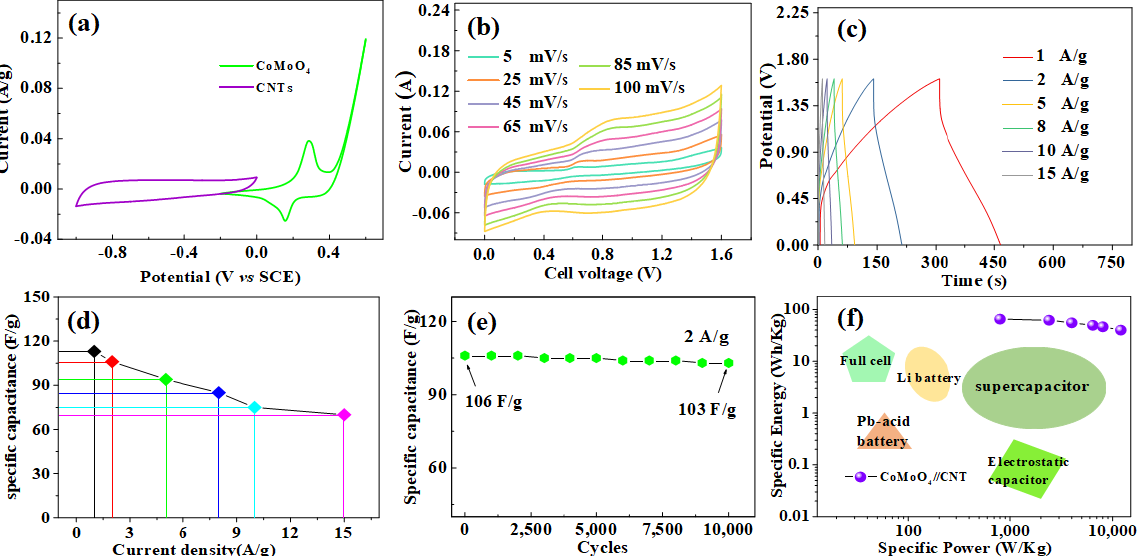
Figure 6. ( a ) CV curves of CNTs and pie-shaped CoMoO 4 electrodes performed in a three-electrode cell in a 2 M KOH electrolyte at a scan rate of 20 mV/s. ( b ) Cyclic voltammetry of the CoMoO 4 //CNT device tested at different sweep rates. ( c ) Charge–discharge curves of the CoMoO 4 //CNT device electrode at different current densities. ( d ) Specific capacitance diagram of CoMoO 4 //CNTs under different current densities. ( e ) Cycle performance of CoMoO 4 // CNT device for 10,000 times at the current density of 2 A/g. ( f ) Energy comparison diagram of various types of energy storage devices.